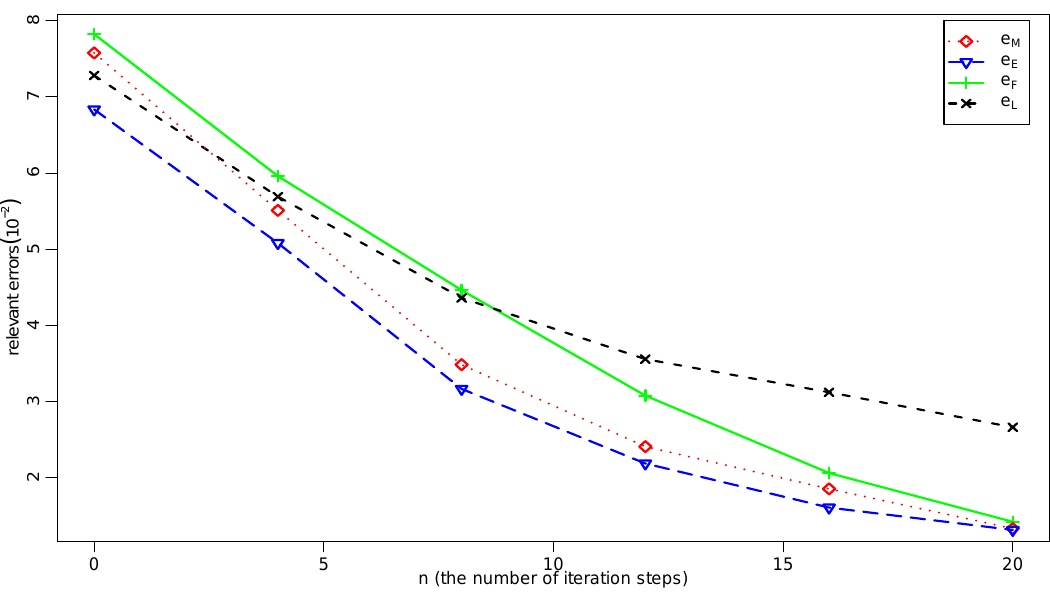
Figure 1. Comparison of the relevant errors in